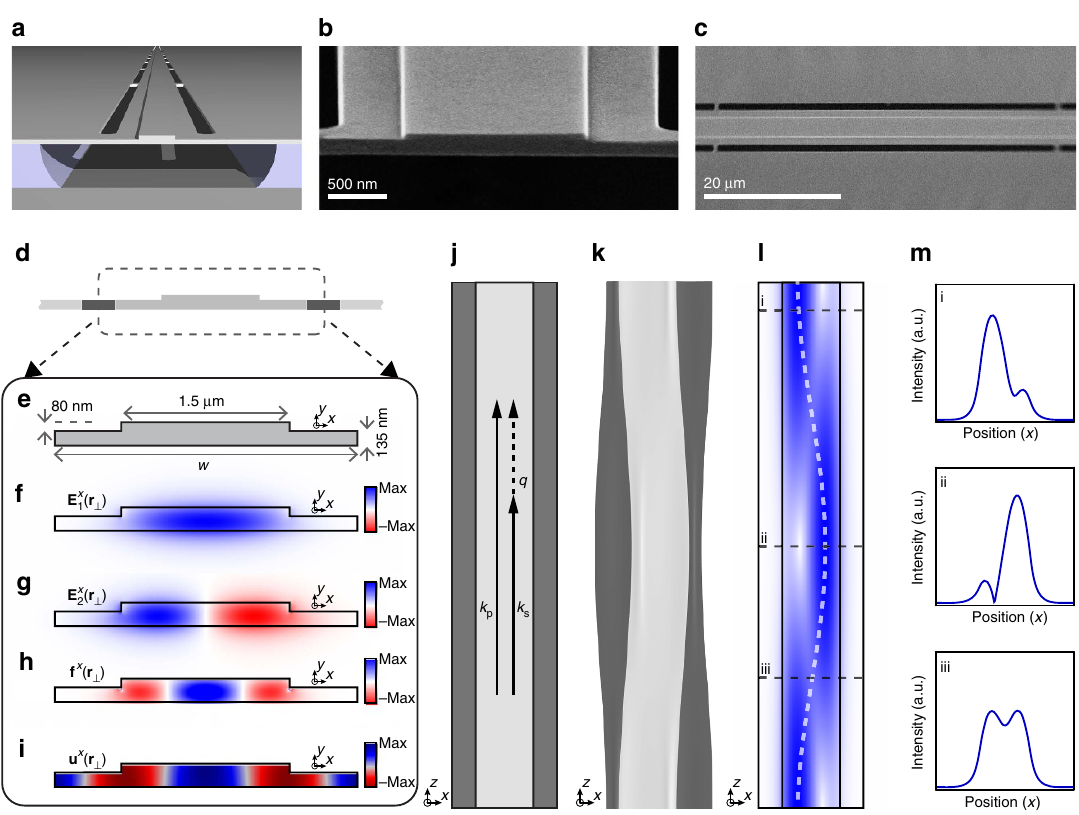
Figure 2 | SIMS-active waveguide. ( a ) Schematic of suspended Brillouin-active waveguide ( b ) SEM of device cross-section. The scale bar represents 500nm in length. ( c ) Top-down SEM of suspended device, with a scale bar representing 20 m m. ( d ) Diagram of device cross-section. Dashed region is plotted in ( e ) with relevant dimensions listed. ( f , g ) are E x fields of the first two guided optical modes. ( h ) x -component of the electrostrictive force generated by these optical modes. ( i ) x -displacement field of the B 6GHz Brillouin-active acoustic mode. ( j – l ) sketch top-down views of a 14 m m long section of the device including phase matching ( j ), elastic displacement for the membrane and ridge regions ( k ), and intensity beating of the two propagating optical modes ( l ). Three slices of the intensity profile in l are plotted in m